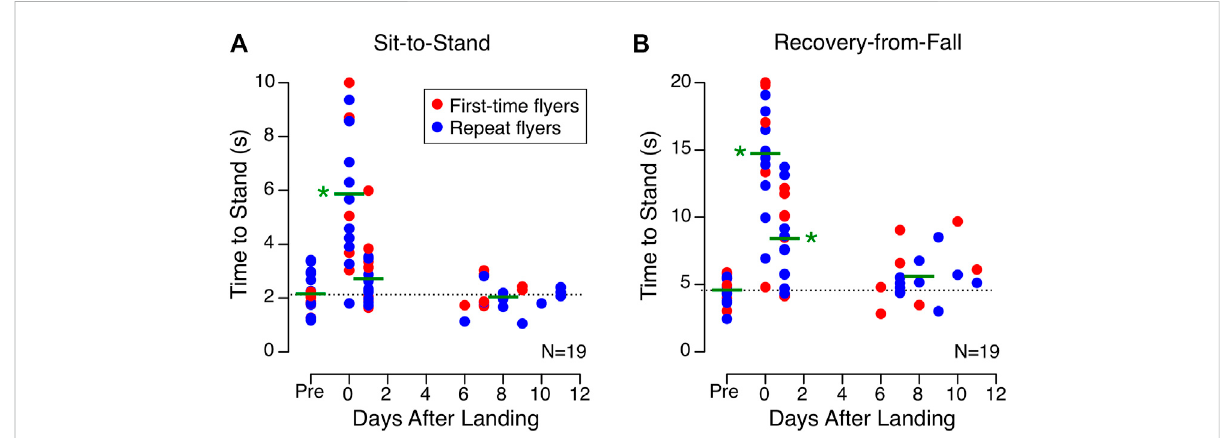
FIGURE 3 Balance tasks. Time required to assume a stable standing posture from a seated position (A) and a prone position (B) for 19 astronauts before (Pre) and after space fl ight. Each symbol represents the data from an individual subject and the horizontal blue lines represent the subjects mean for each major time point. The dotted line represents the mean of all pre fl ight measures. * p < 0.05 relative to pre fl ight